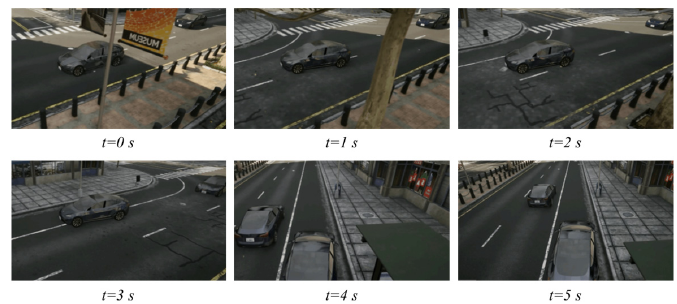
Figure 17. An example of Carla simulations.